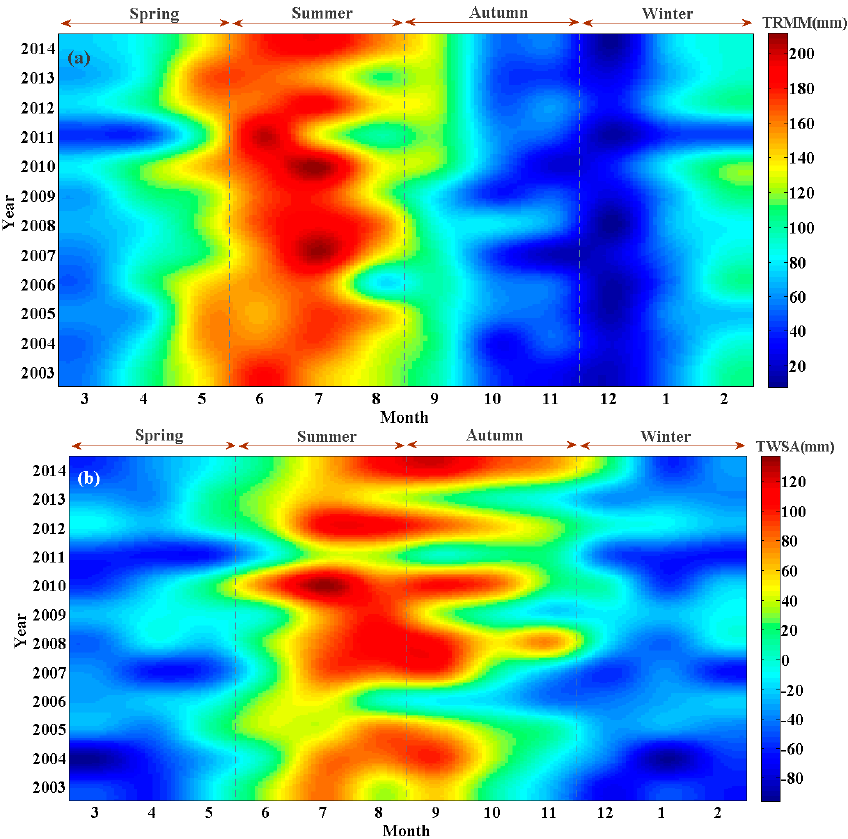
Figure 5. Seasonal characteristics of ( a ) monthly precipitation derived from TRMM-3B43 data and ( b ) the GRACE-derived terrestrial water storage anomaly (TWSA) in the Yangtze River Basin from 2003 to 2014.